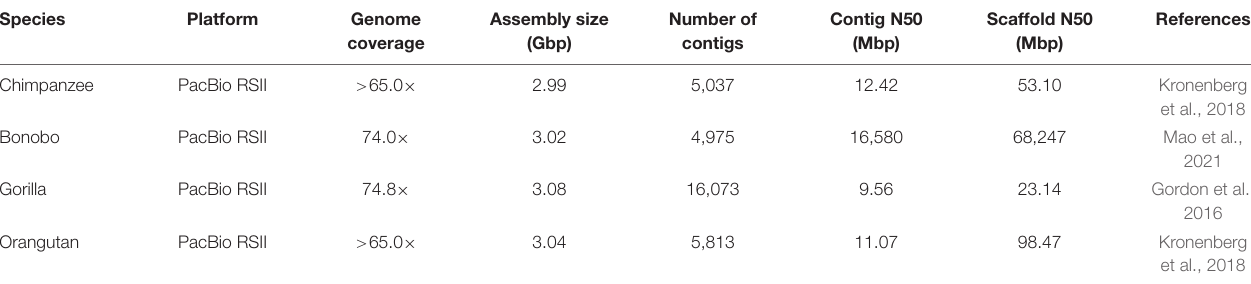
TABLE 1 | A summary of whole-genome sequencing in great apes.